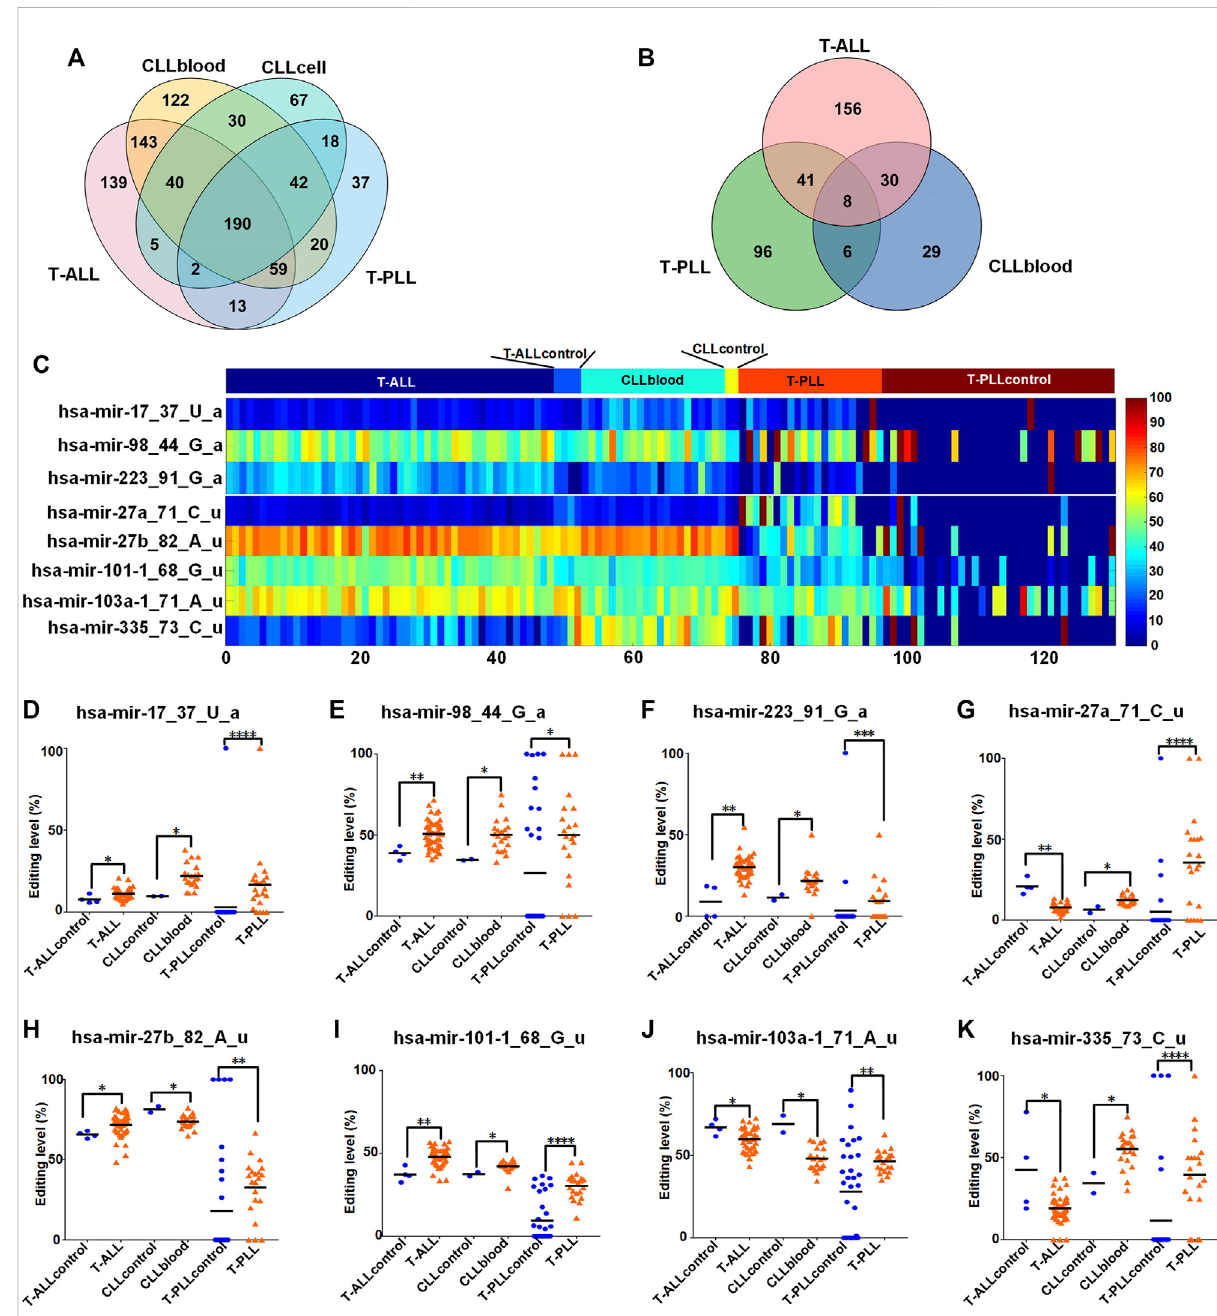
FIGURE 3 Comparisons of M/E sites in different subtypes of leukemia (A) The Venny diagram of miRNA editing events in T-ALL, CLLblood, CLLcell, and T-PLL leukemia samples. (B) The Venny diagram of M/E sites with signi fi cantly different editing levels in T-ALL, CLLblood and T-PLL compared with their corresponding controls, respectively. The M/E sites with p < 0.05, Mann-Whitney U -tests in T-ALL, CLLblood and T-PLL were compared and shown in fi gure (C) The editing levels of 8 M/E sites with signi fi cantly different present in T-ALL, CLLblood, and T-PLL samples and their normal control samples. (D – K) The comparisons of editing levels of these 8 M/E sites in each leukemia and its normal control samples. In Part (D – K) , “ **** “ , “ *** “ , “ ** “ , and “ * ” indicate p -values < 0.0001, 0.001, 0.01 and 0.05, respectively, Mann-Whitney U